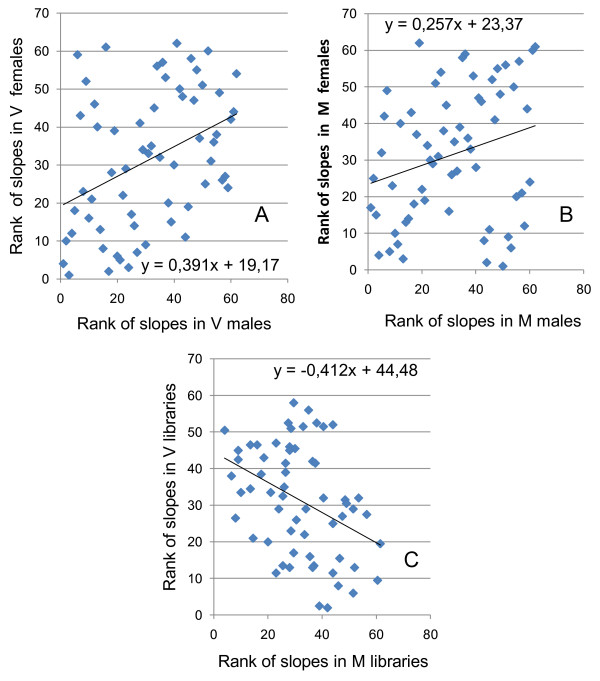
Comparison of the slopes of the regression lines between age and the absolute residual values. A) The slopes of males and females correlate in V libraries (P = 0,00166). B) The slopes of males and females correlate also in M libraries (P = 0,043). C) The slopes of M libraries and V libraries correlate also (P = 0,00164) but this correlation is negative !